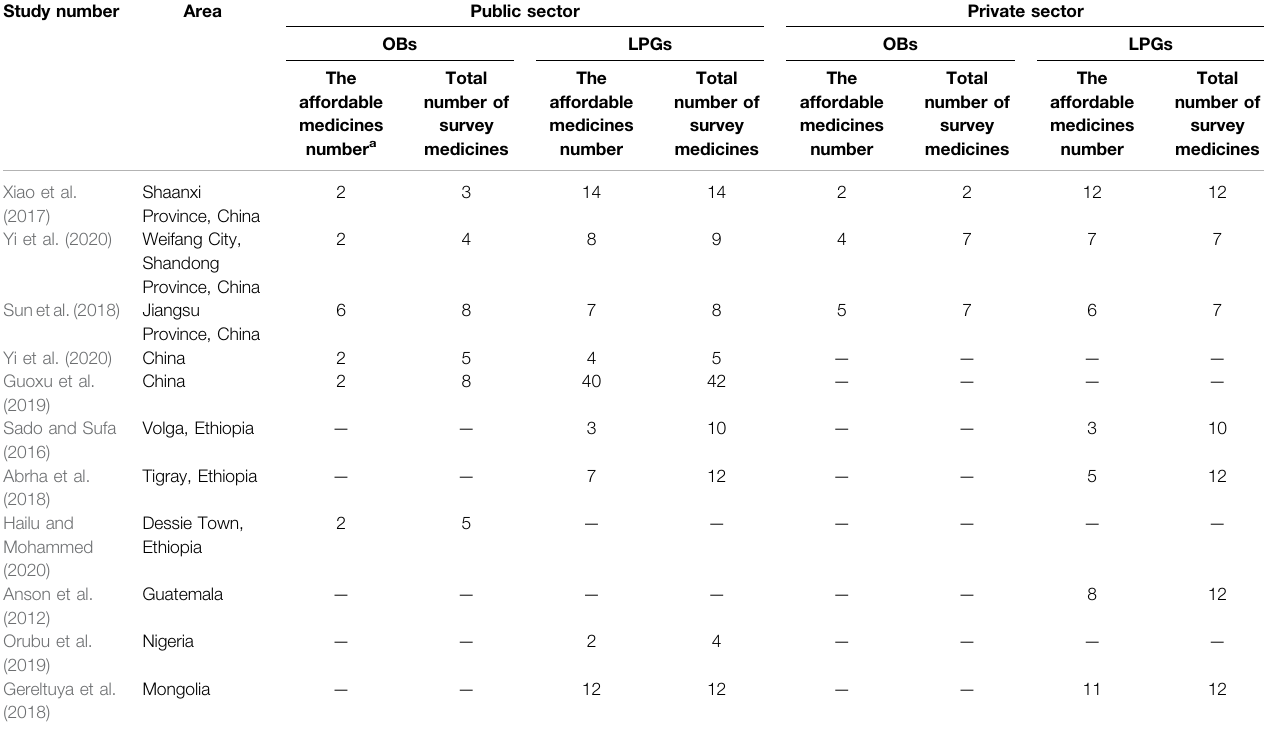
TABLE 5 | Affordability of medicines for